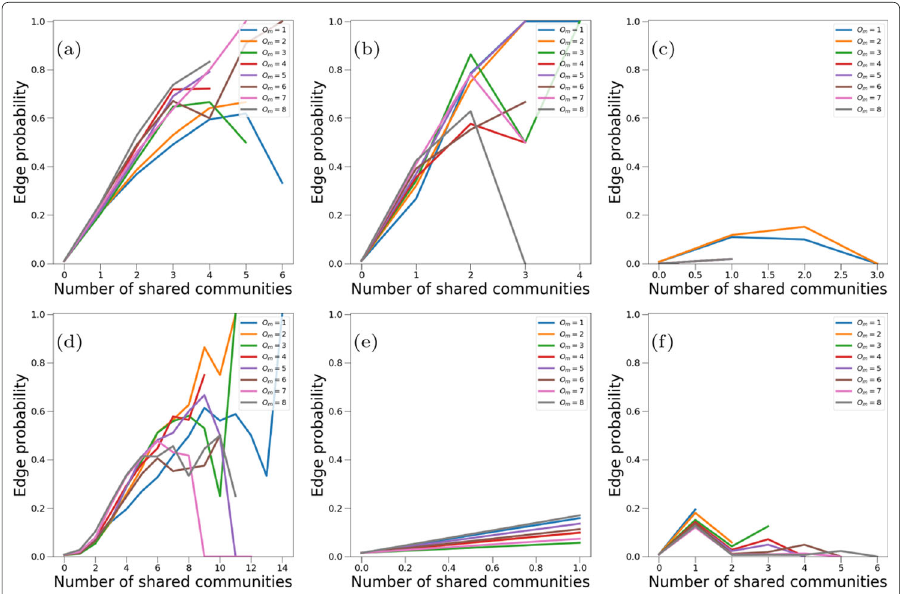
Fig. 26 Variation of the maximum number of memberships ( O m ) for LFR synthetic networks considering the edge probability: a Bigclam; b CFinder; c Copra; d Demon; e SLPA; f